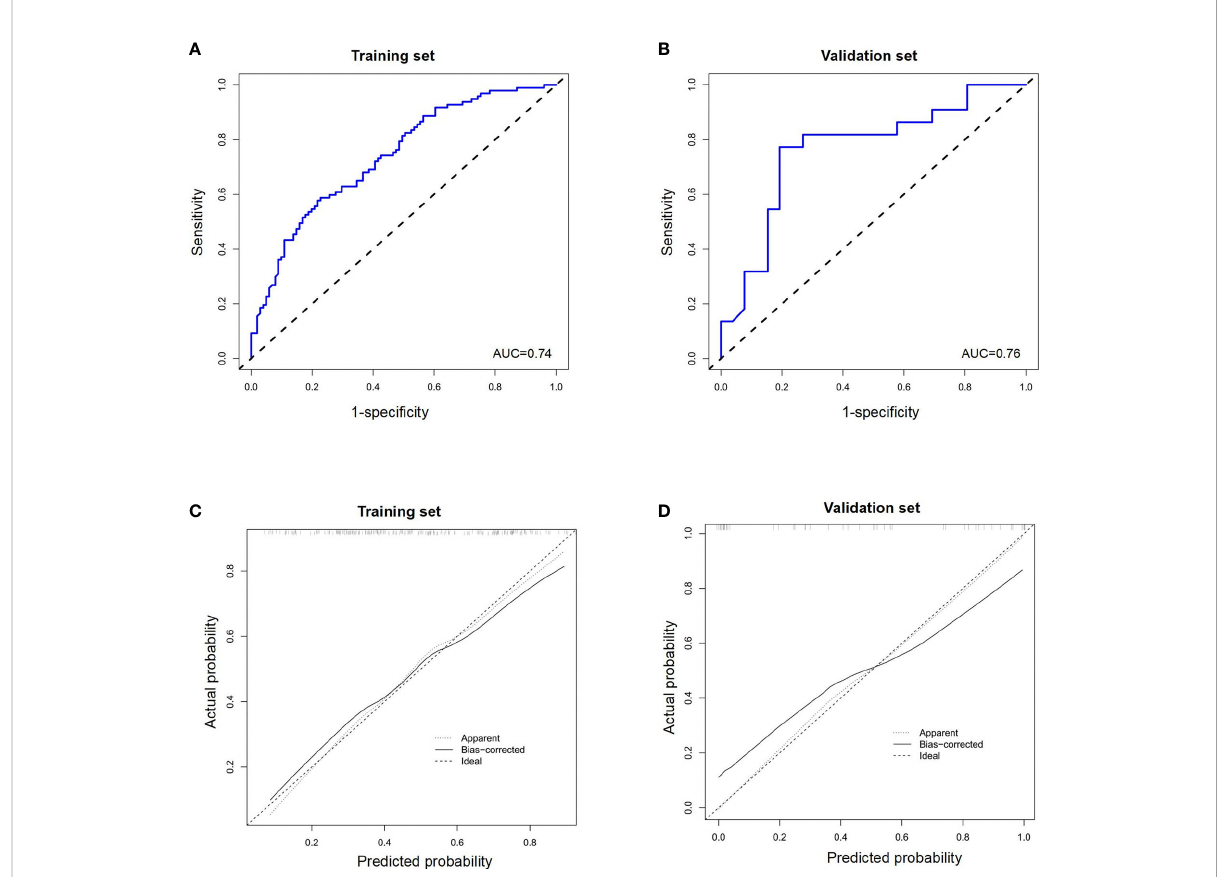
FIGURE 4 The receiver operating characteristic (ROC) curves of a nomogram for predicting the probability of apCR in (A) the training set and (B) validation set. Calibration curves of a nomogram for predicting the probability of apCR in the training set (C) and validation set (D) . apCR, axillary lymph node pathological complete